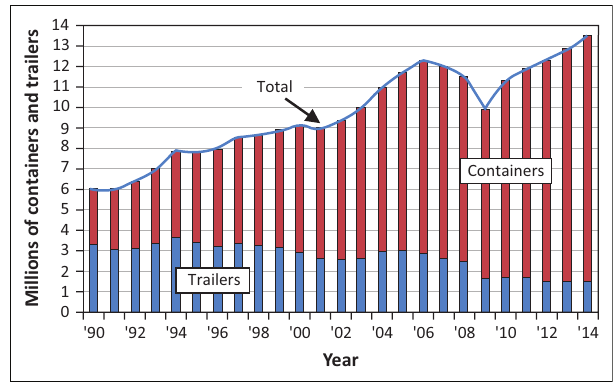
FIGURE 2: United States rail intermodal traffic (millions of containers and